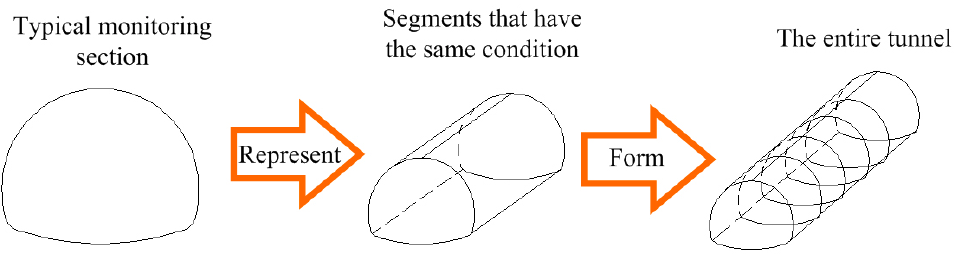
Figure 2. The evaluation processing diagram of long-term health of the tunnel structure.